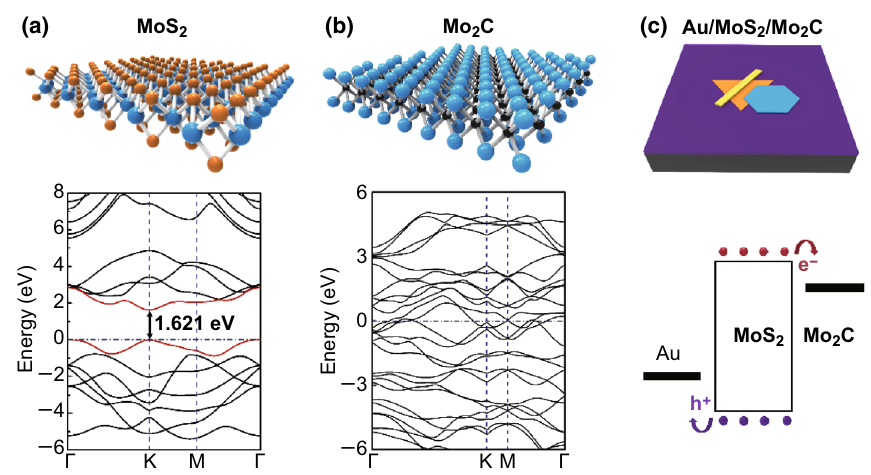
Fig. 1 Schematic illustration (top) and calculated electronic band structure (bottom) of a monolayer MoS 2 and b monolayer Mo 2 C. c Schematic diagram (top) and energy band diagram (bottom) of MoC 2 /MoS 2 /Au